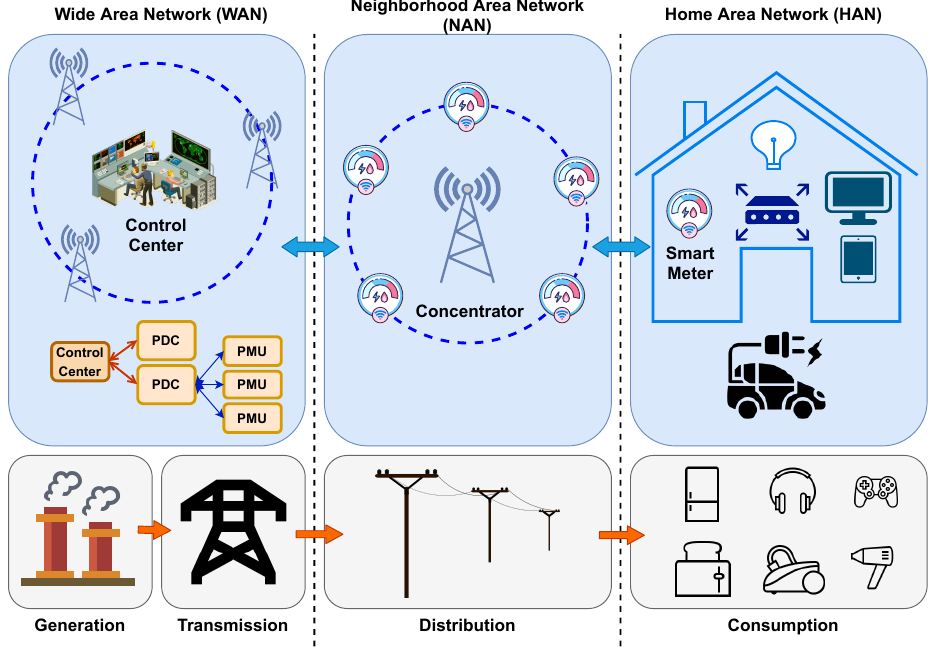
Figure 1. The architecture of a smart